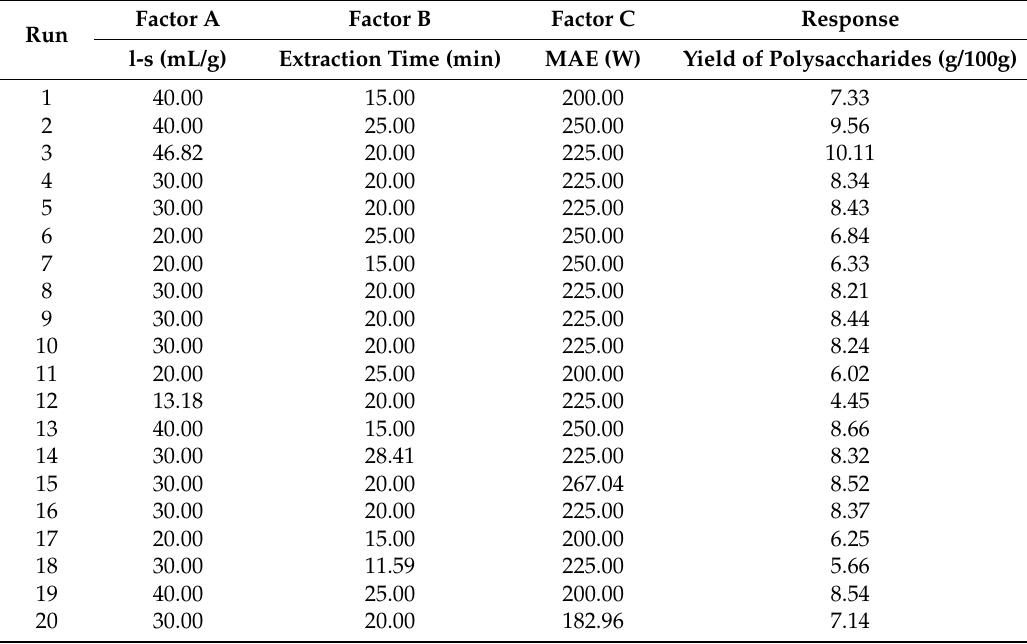
Table 8. Experimental design matrix to screen important variables for microwave-assisted extraction. Factor C